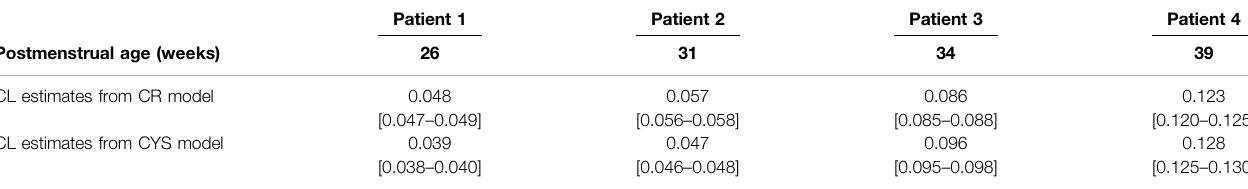
TABLE 5 | Individual vancomycin clearance estimates from CR and CYS models for four typical patients (1,000